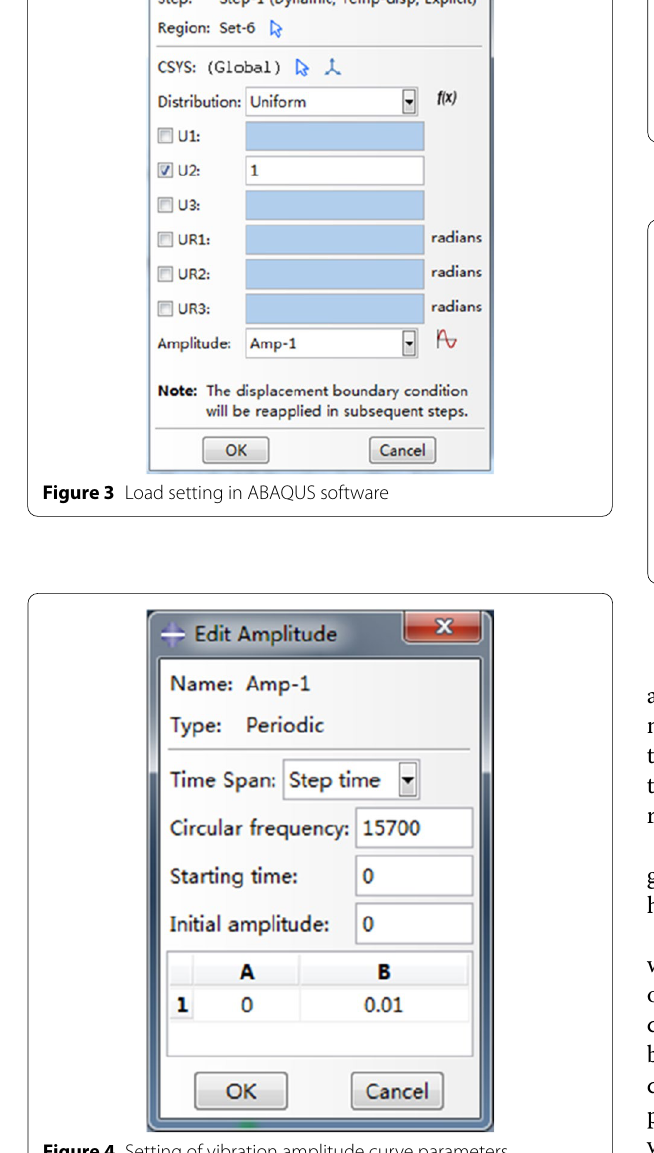
Figure 4 Setting of vibration amplitude curve parameters